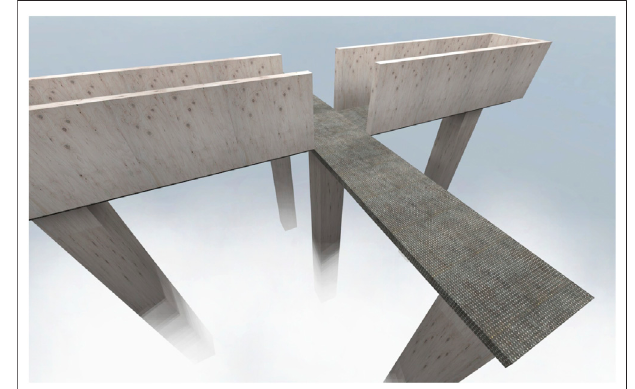
FIGURE 1 | Screenshot of the virtual Elevated Plus-Maze. Center area marks the starting point of the exploration phase lasting for 5 min; starting gaze direction was randomized across